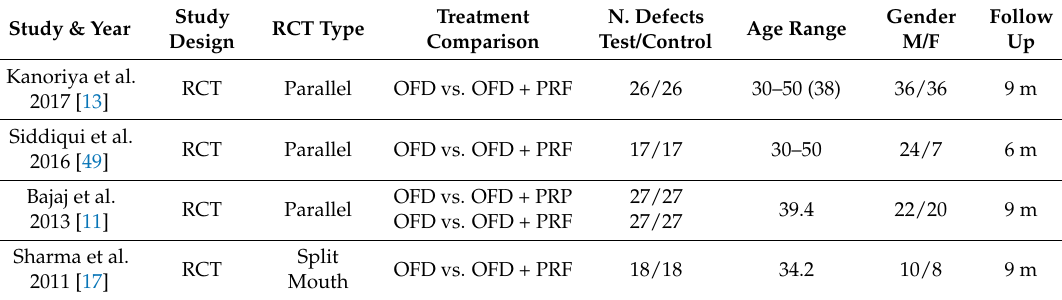
Table 3. Characteristics of included